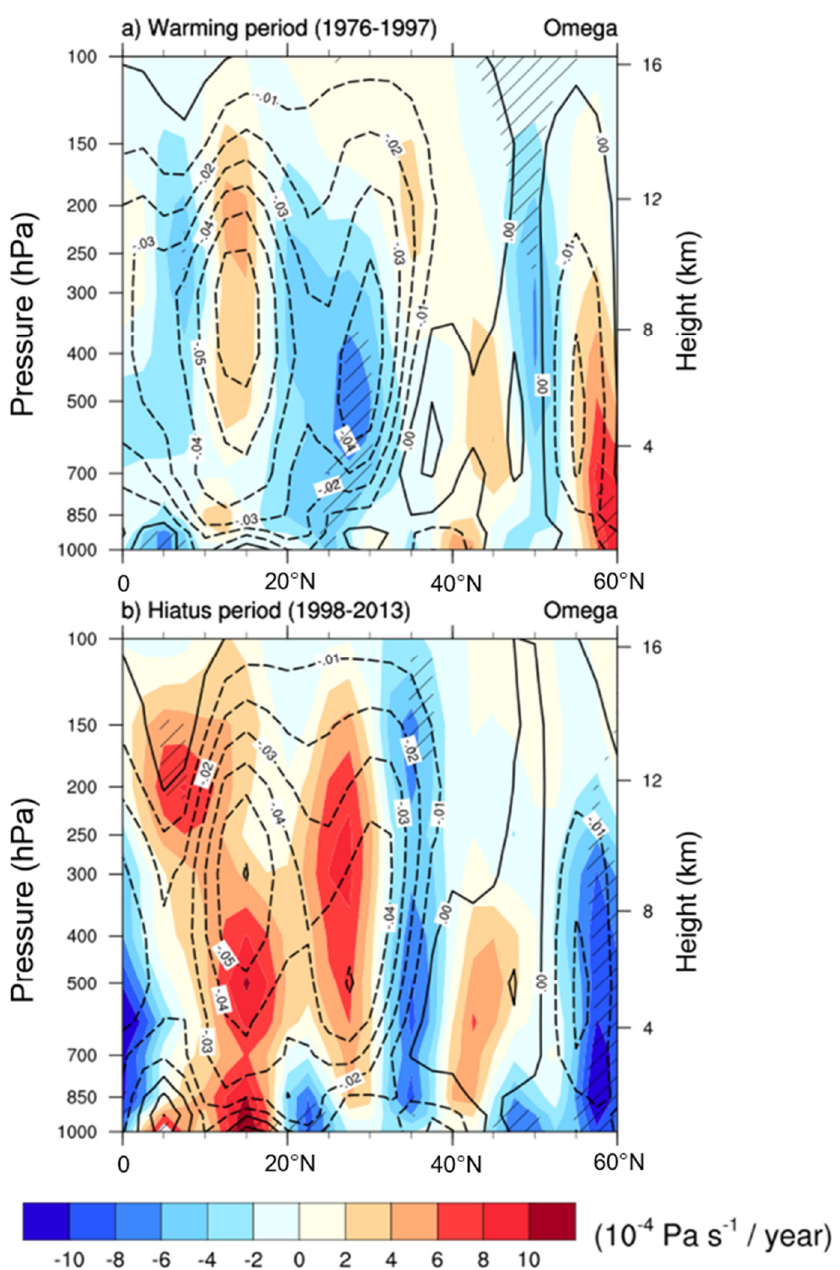
Figure 3. Climatological mean omega (contours) and trend (shading) averaged from 110 ◦ E–122.5 ◦